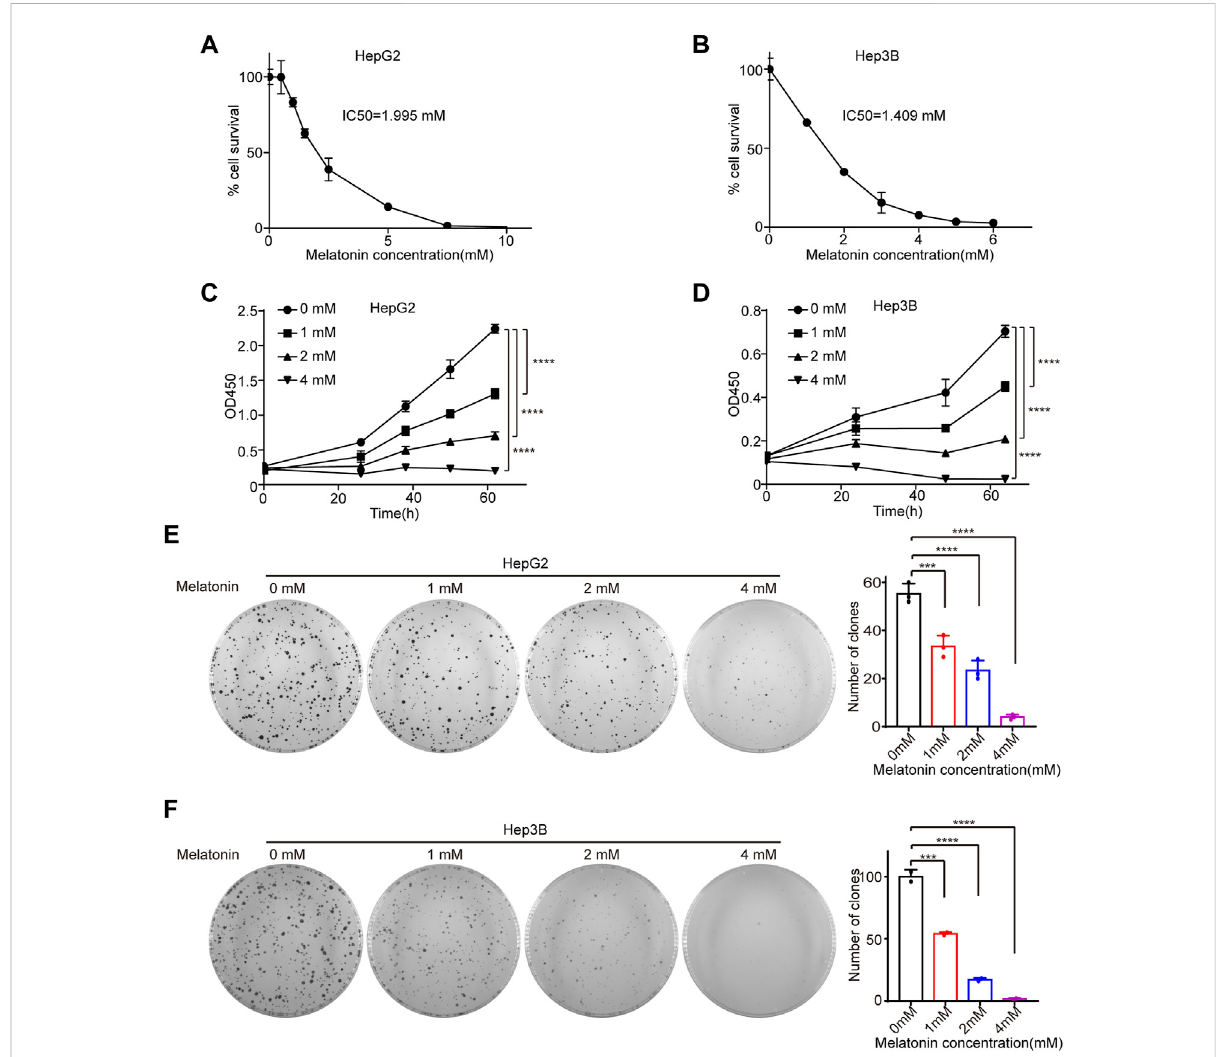
FIGURE 1 Melatonin inhibits cell proliferation. (A) HepG2 cells were treated with gradient concentrations of 0, 0.5, 1, 1.5, 2.5, 5, 7.5, 10 mM melatonin for 72 h, and cell viability was measured by CCK8 assay. (B) Hep3B cells were treated with gradient concentration of 0, 1, 2, 3, 4, 5, 6 mM melatonin for 72 h, and cell viability was measured by CCK8 assay. IC50 were calculated using GraphPad Prism. (C,D) The cell viability of HepG2 cells and Hep3B cells treated with gradient concentration of 0, 1, 2, 4 mM melatonin for 62 h, was measured by CCK8 assay at intervals, with p values calculatedbytwo-wayANOVA. (E,F) TheproliferationofHepG2cellsandHep3Bcellstreatedwithgradientconcentrationof0,1,2,4 mMmelatonin was examined with colony formation assay. Images of the whole plate are shown. The mean ± SD of relative colony numbers was plotted and p values calculated by one-way